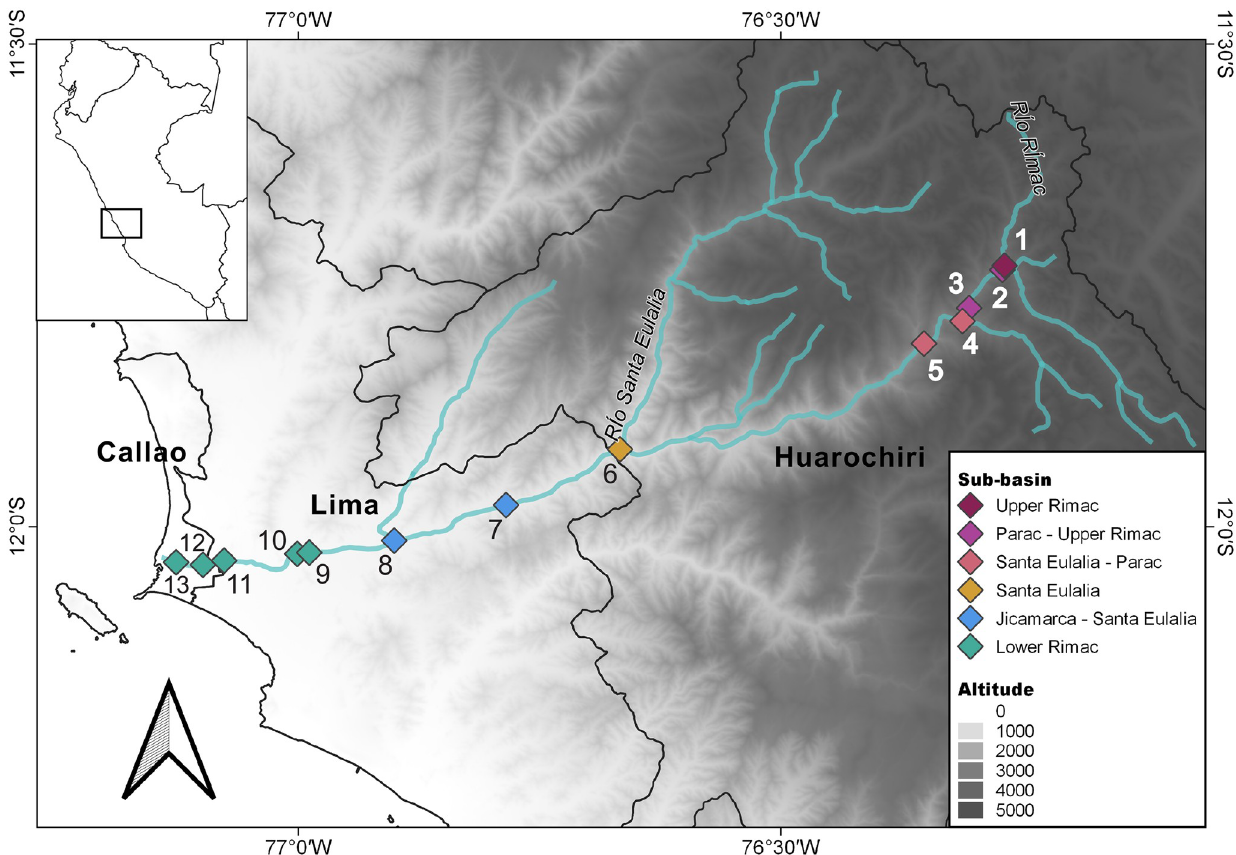
Fig 1. Area of study and sampling localities. The Rimac basin is situated between the central Peruvian Andes and the Pacific Ocean. The river runs across Callao, Huarochiri and Lima provinces in the Lima region. We sampled in different localities from the following sub-basins: Upper Rimac, 1. Chicla; Parac- Upper Rimac, 2. San Mateo, 3. Tamboraque; Santa Eulalia-Parac, 4. Huanchor, 5. Chacahuaro; Santa Eulalia, 6. Santa Eulalia; Jicamarca-Santa Eulalia, 7. Chaclacayo, 8. Huachipa; Lower Rimac (Metropolitan area), 9. Libertadores, 10. Nuevo, 11. Universitaria, 12. Faucett, 13. Gambetta.